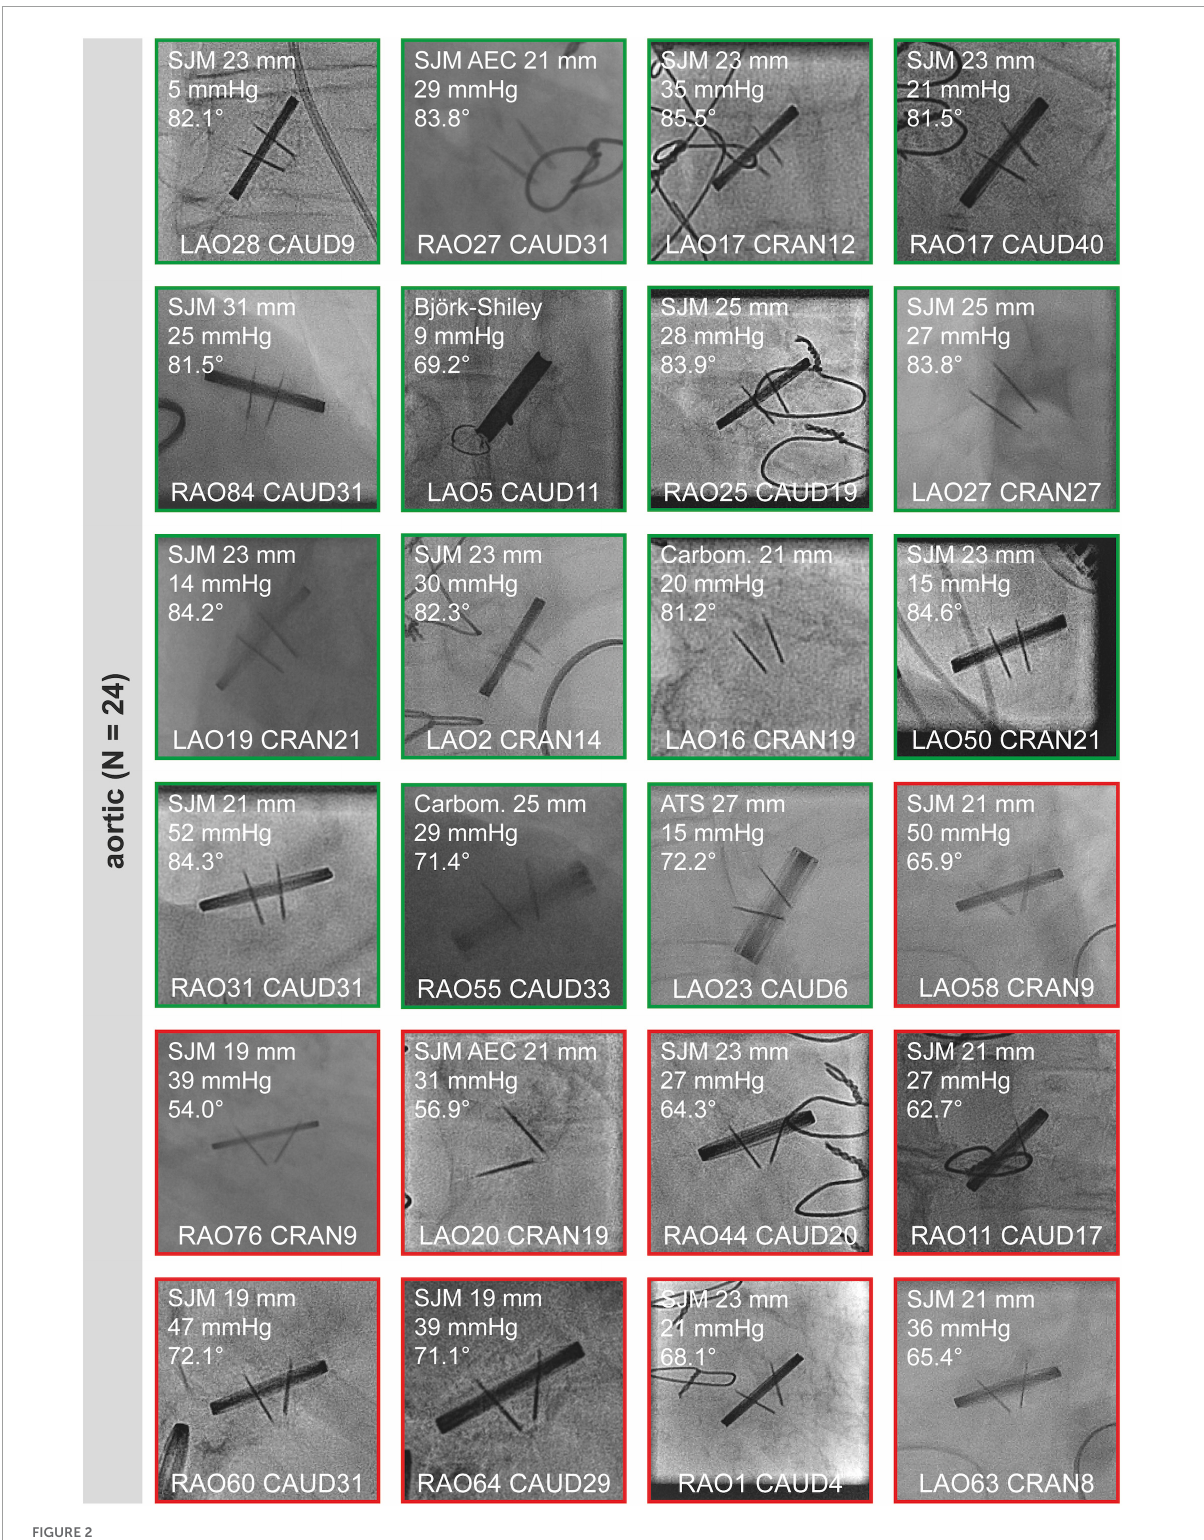
FIGURE2 Sufficient cinefluoroscopy studies of MHVs in aortic position. MHVs had either normal leaflet opening and closing (green) or leaflet dysfunction (red). MHVs are shown during maximum opening. Individual images show the opening angle (for details refer to Figure 1 ), mean gradient from transthoracic echocardiography, and projection angles in CF. For comparison, the mean opening angles of SJM, ATS, and Carbomedics MHVs are 83.4, 69.5, and 77.1 ◦ , respectively (12). Some images are already shown in Figure 1 . AEC, aortic valve extended cuff; ATS, ATS Medical; Carbom., Carbomedics; CAUD, caudal; CRAN, cranial; LAO, left anterior oblique; MHV, mechanical heart valve; RAO, right anterior oblique; SJM, St. Jude